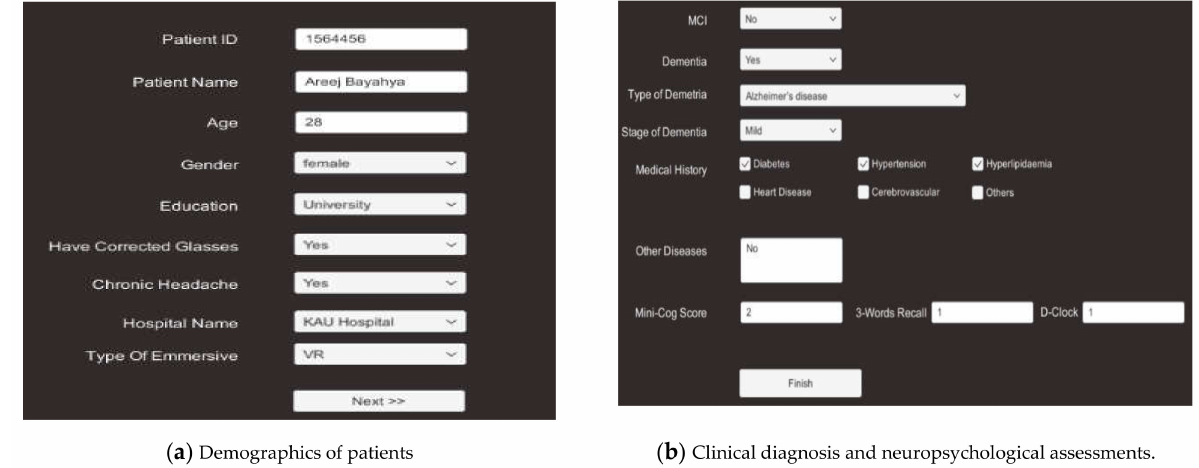
Figure 3. Demographics of clinical and medical history, clinical diagnosis, and neuropsychological